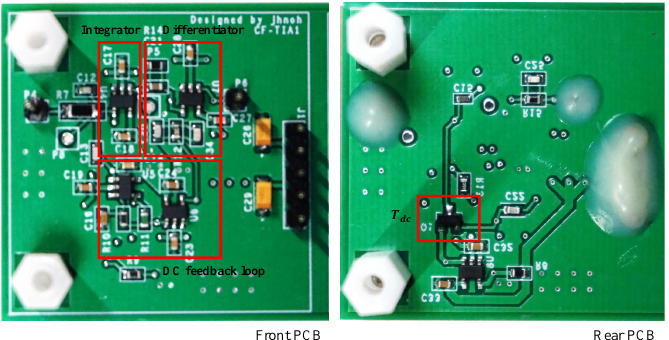
Figure 5. Hardware Implementation.